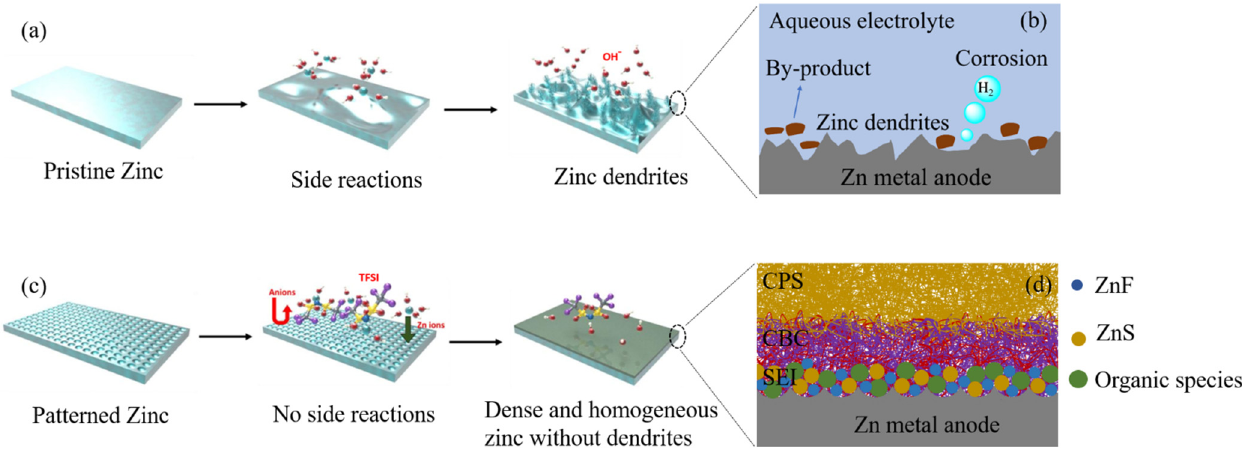
Figure 20. Schematic representation of the zinc anode interaction with liquid and solid-state elec- trolytes. ( a , b ) Conventional zinc anode in aqueous alkaline electrolyte (6 M KOH) promote the side reactions and zinc dendrites formation. ( c , d ) In contrast, the patterned zinc anode with CBCs solid-state electrolyte form a robust and uniform SEI layer lacking any side reactions [83]. Schematic figure ( b ) and ( d ) depicts illustration of interfacial region and SEI formation, respectively. Reprinted with permission from Ref. [83], Copyright 2021, Springer Nature.